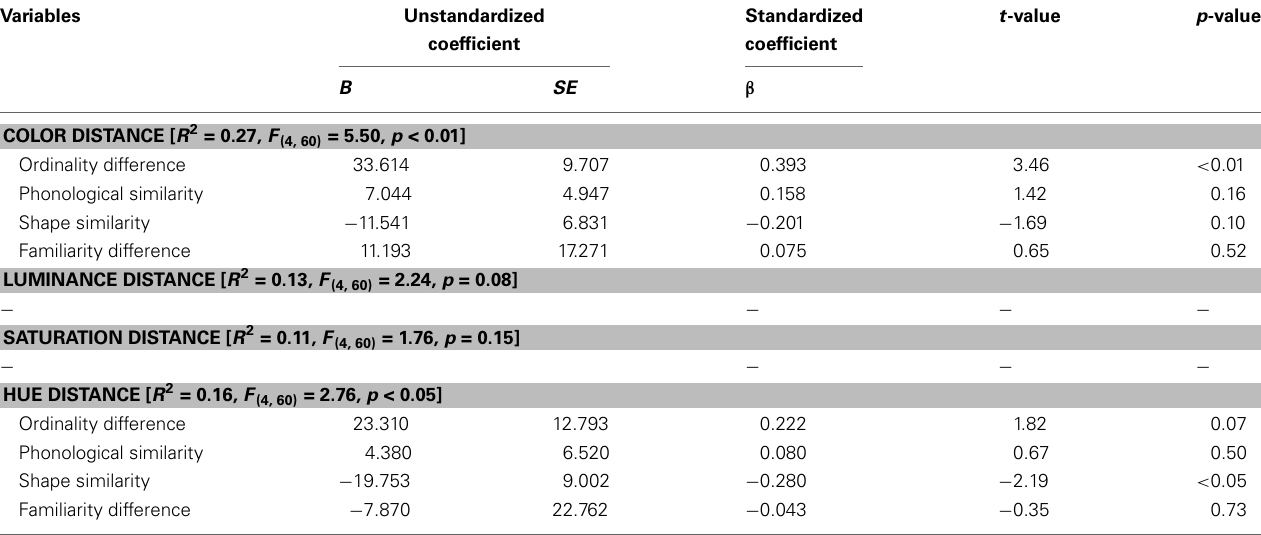
Table 4 | Results of multiple regression analyses for English alphabet letter pairs.